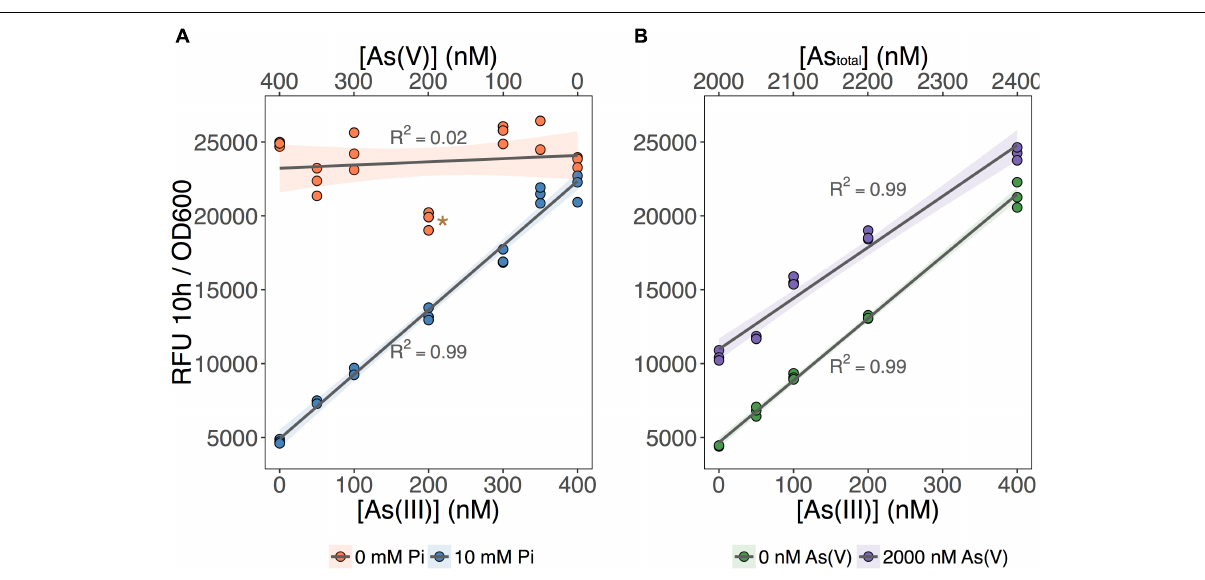
FIGURE 3 | As(III) can be detected independent of As(V) concentration. (A) The biosensor was exposed to samples that contained 400 nM total inorganic arsenic and variable input concentrations of As(V) and As(III), indicated on the upper and lower x -axes. MGP (0 mM Pi) and MIP (10 mM Pi) exposure media were used for detection of total inorganic arsenic and As(III), respectively. (B) As(III) was detected using MIP exposure media in samples containing 0 nM or 2000 nM As(V). Input concentrations of As(III) are presented on the x -axis. On both plots, triplicate RFU per OD 600 treatment points are presented rather than means with error bars. The star indicates a statistically significant difference in output signals when compared to the regression